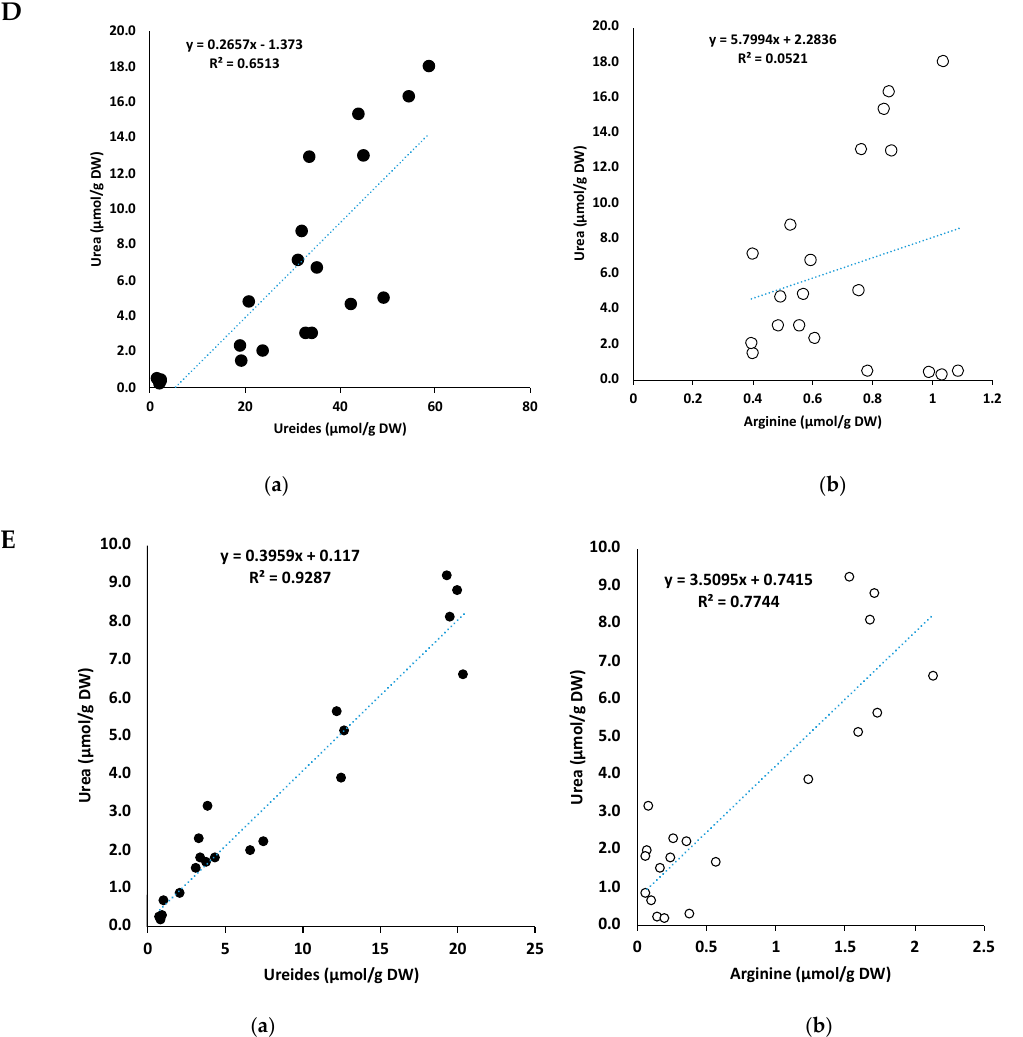
Figure 8. ( A ) Correlations between the concentrations of ureides and urea ( a ) and arginine and urea ( b ) in the soybean xylem sap. ( B ) Correlations between the concentrations of ureides and urea ( a ) and arginine and urea ( b ) in the soybean nodules. ( C ) Correlations between the concentrations of ureides and urea ( a ) and arginine and urea ( b ) in the soybean roots. ( D ) Correlations between the concentrations of ureides and urea ( a ) and arginine and urea ( b ) in the soybean stems. ( E ) Correlations between the concentrations of ureides and urea ( a ) and arginine and urea ( b ) in the soybean leaves.